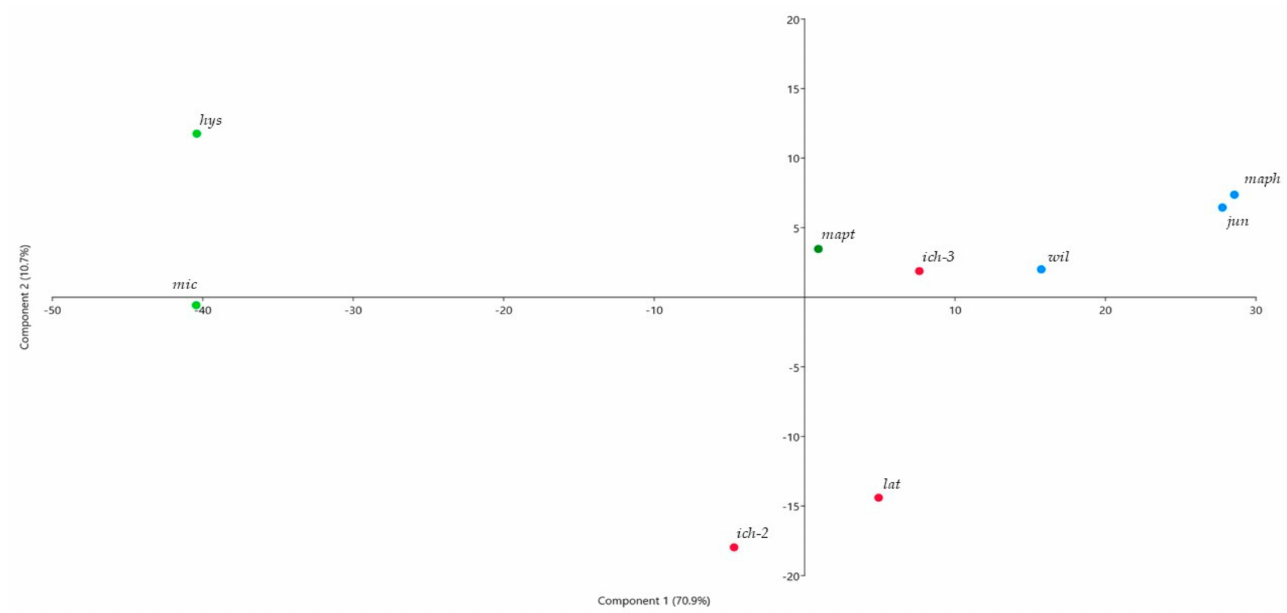
Figure 1. Principal Component Analysis performed on peel oil samples (components higher than 2%). Green: hys : C. hystrix , mic : C. micrantha , mapt : C. macroptera ; Red: lat : C. latipes , ich : C. ichangensis ; Blue: wil : C. wilsonii , jun : C. junos , maph : C. macrophylla